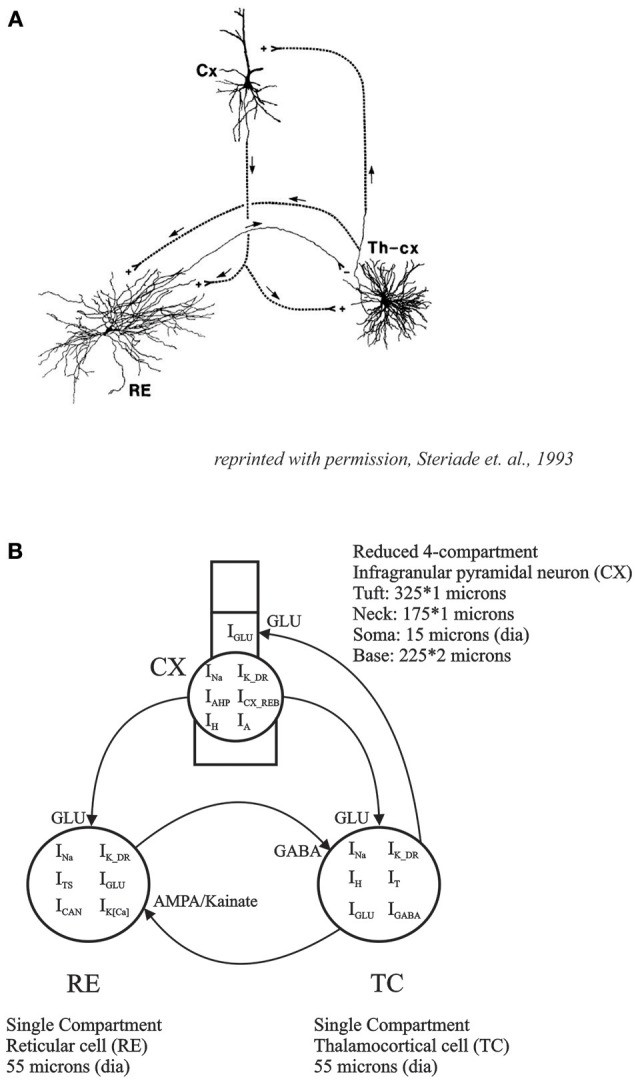
(A) Basic thalamo-cortical circuit consists of reciprocal excitatory connections between TC and CX neurons with collaterals to RE. RE neurons have inhibitory projections to TC (reprinted with permission, Steriade et al., 1993a). (B) Thalamo-Reticulo-Cortical network model developed for simulations in the current study. This computational model with anatomically realistic connections is an implementation of the proposed circuitry for the neural basis of thalamocortical oscillations.